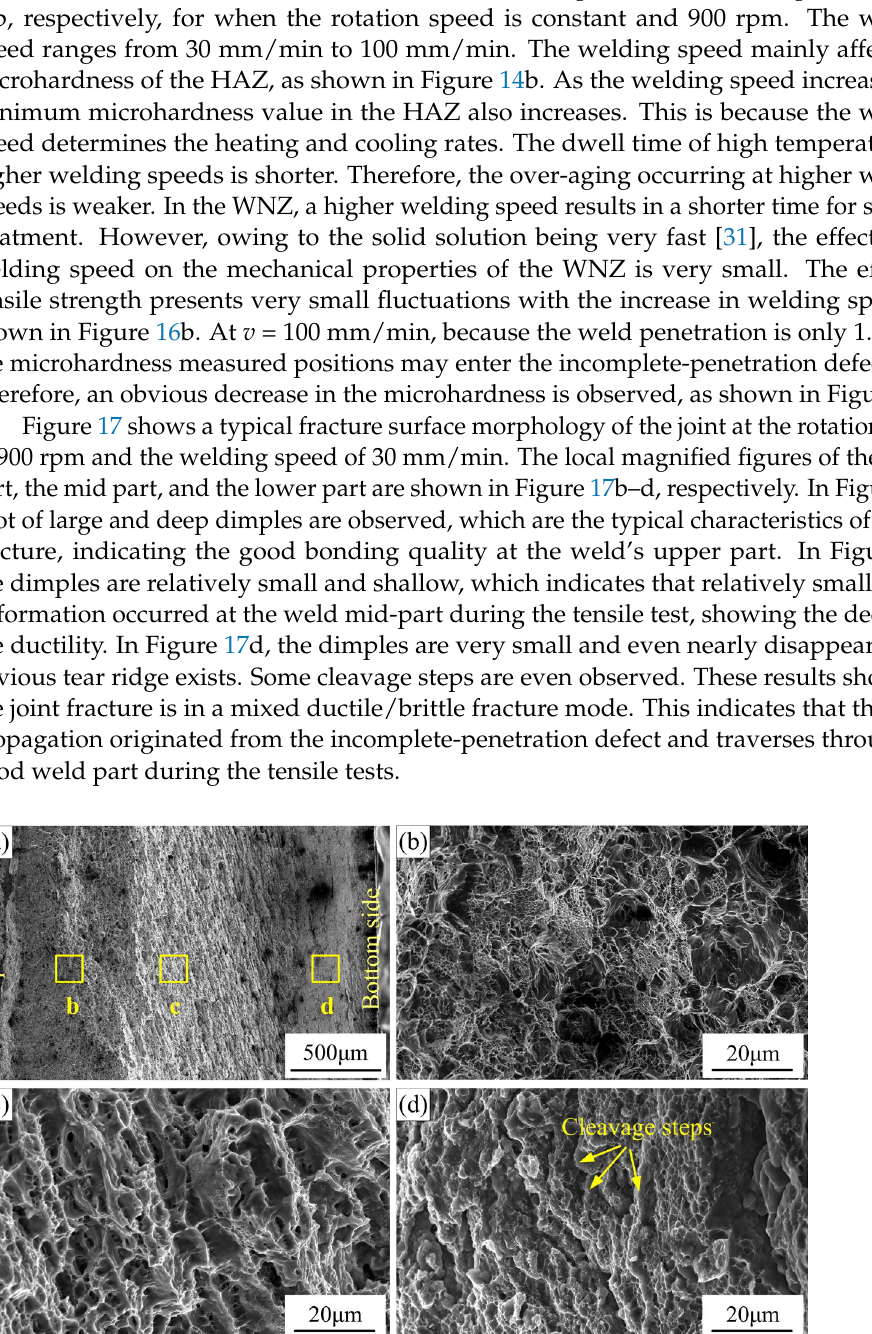
Figure 16. Relationship between the effective tensile strength and the welding parameters: ( a ) weld penetration to rotation speed; ( b ) weld penetration to welding speed; ( d = 12 mm).